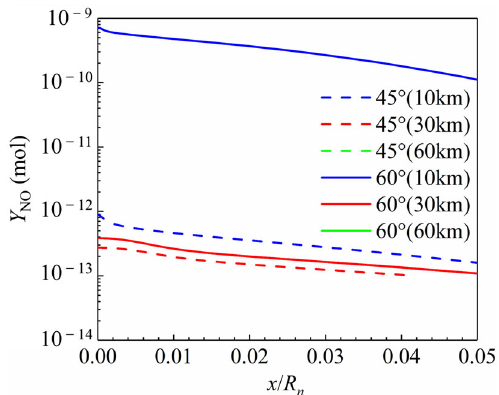
Figure 9. Mole faction of NO along the stagnation line.